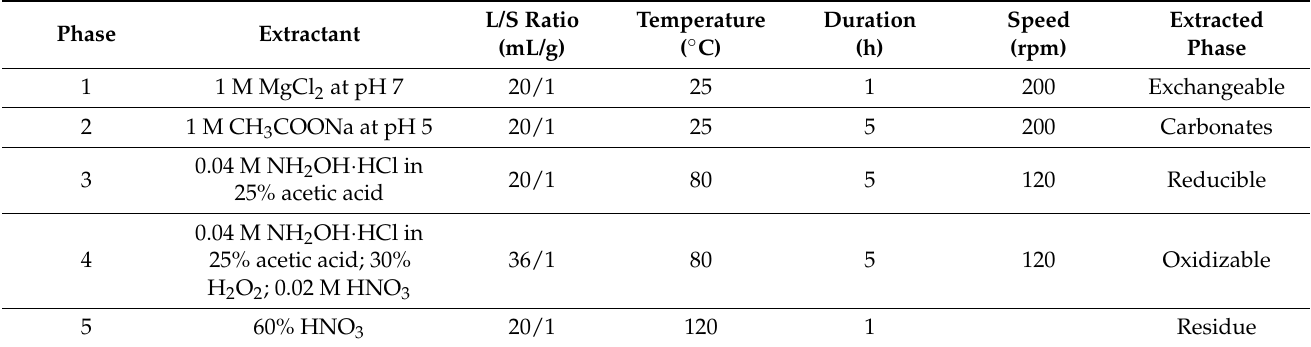
Table 1. Procedure for the Determination of the Solid-Phase Partitioning of Pb and